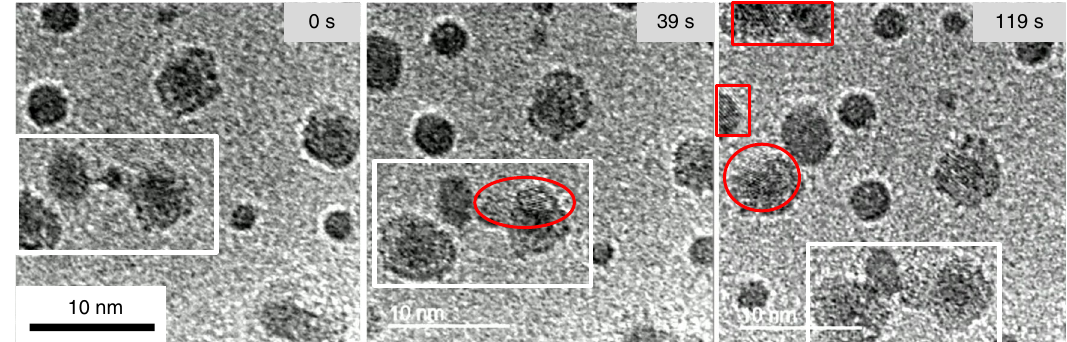
Fig. 3 The coalescence process of the large NPs with the long time irradiation. A series of images from Supplementary Movie 4 shows the coalescence process of the large NPs which were exposed under the probe electron beam for 10 min. The large size NPs exhibit a rather slow merging rate as the NP group marked with white frame. The irradiation with the long time induced the observable crystalline lattice fringes in the areas marked with the red